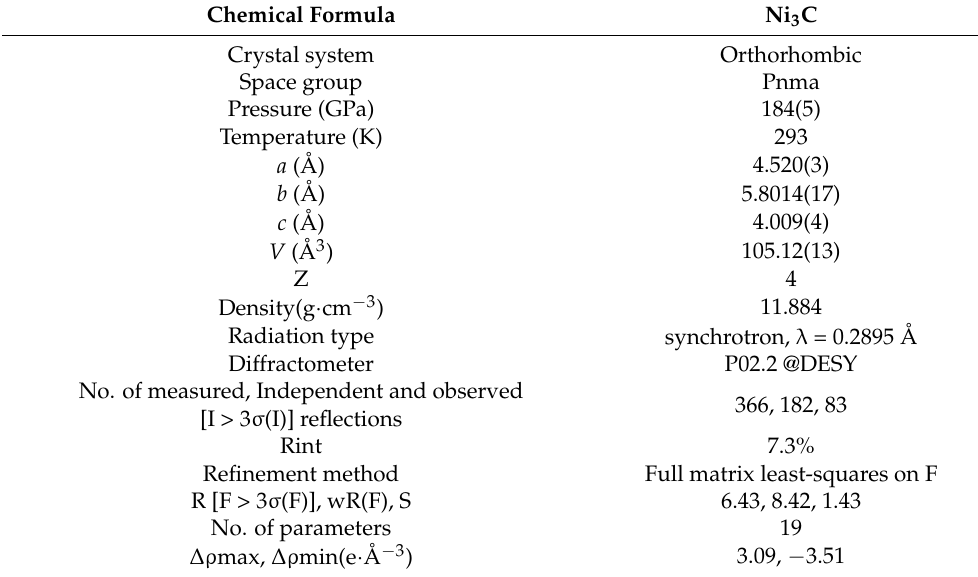
Table 1. Crystallographic data for the Ni 3 C at 184(5) GPa and 293 K.